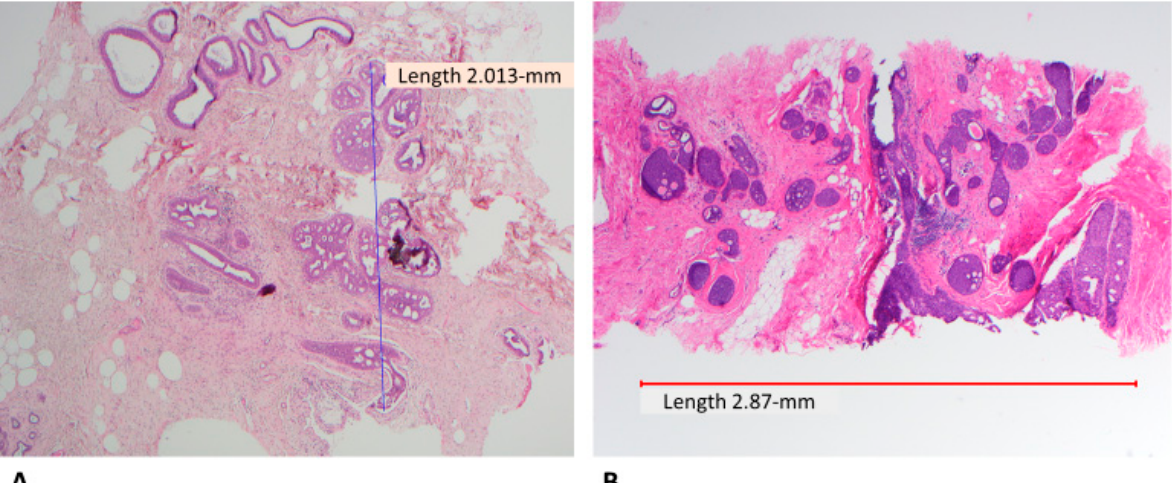
Figure 2. Severe ADH bordering on DCIS; ( A ) atypical intraepithelial ductal neoplasia arranged in cribriform pattern involving more than two spaces and measuring slightly more than 2 mm (H&E, scanning magnification); ( B ) Similar finding but with larger size, some pathologists may designate this as DCIS (H&E, scanning magnification).